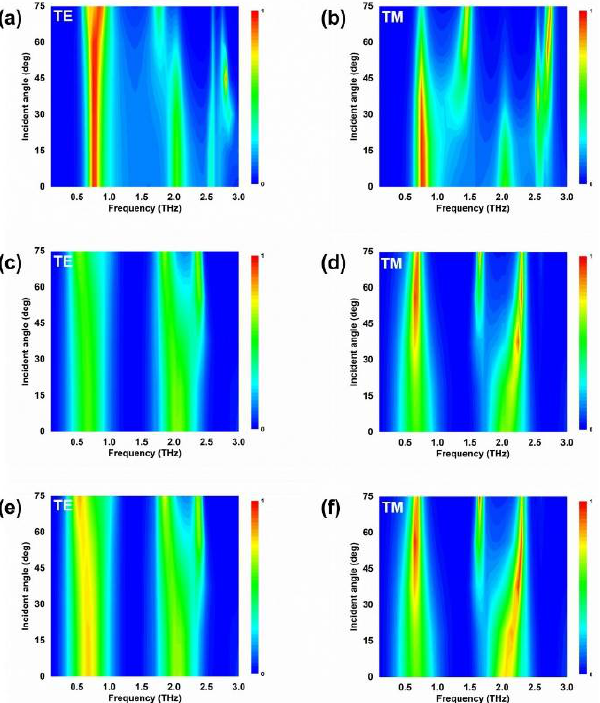
Figure 7. The absorption spectra of the designed disk-patterned graphene THz metamaterial absorber with different incident angle for ( a ) TE polarization and ( b ) TM polarization. The absorption spectra of the designed ring-patterned graphene THz metamaterial absorber with different incident angle for ( c ) TE polarization and ( d ) TM polarization. The absorption spectra of the designed circled minus-patterned graphene THz metamaterial absorber with different incident angle for ( e ) TE po- larization and ( f ) TM polarization.